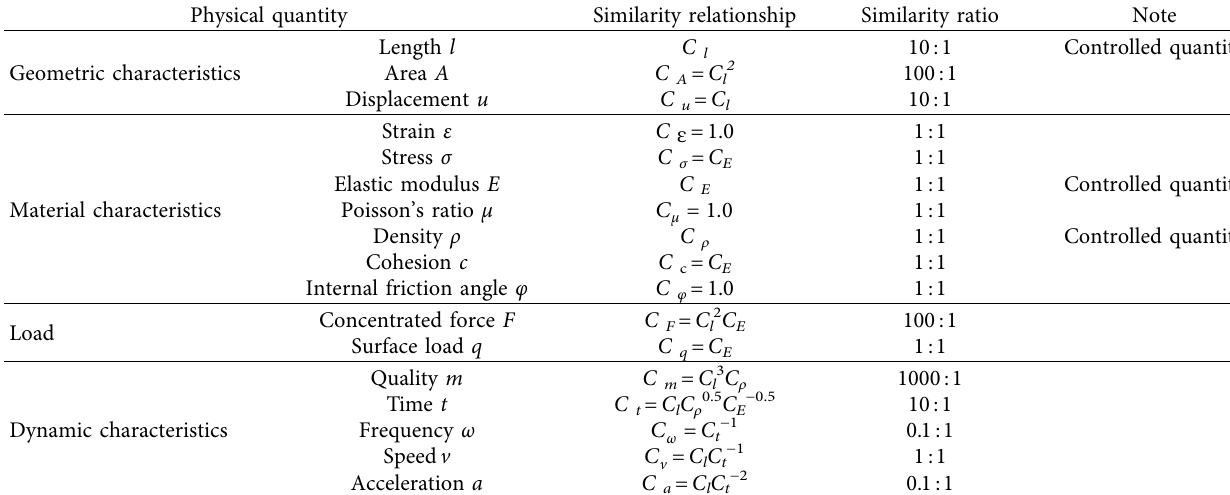
Figure 2: Design drawing of prototype long-short pile composite foundation treatment (unit: m). (a) Cross section of long-short pile composite foundation treatment. (b) Long-short pile composite foundation treatment Table 1: Similarity relation and similarity constant.